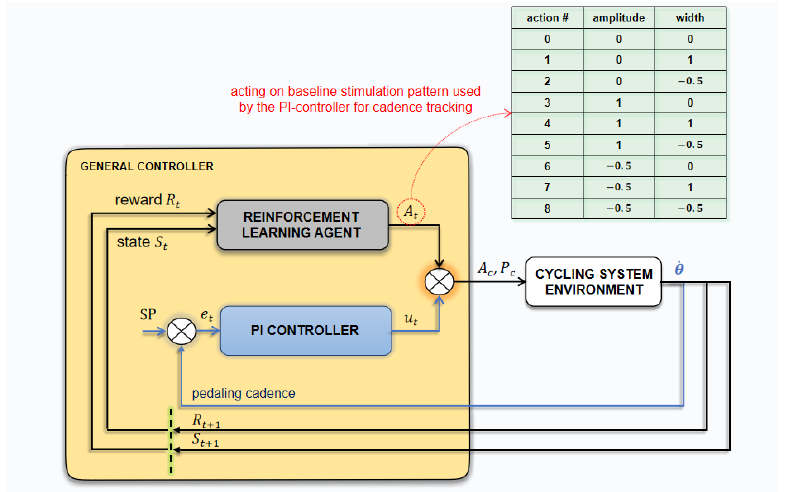
Figure 1. The global control strategy with the agent – environment interaction scheme and the PI- controller. At a state St, the RL agent selects one action for each channel that may change the pulse amplitude and/or width, respecting predefined rules. In parallel, the control contribution from the PI controller for cadence tracking. Signals A c and P c represent the amplitude and pulse width output of the general controller.